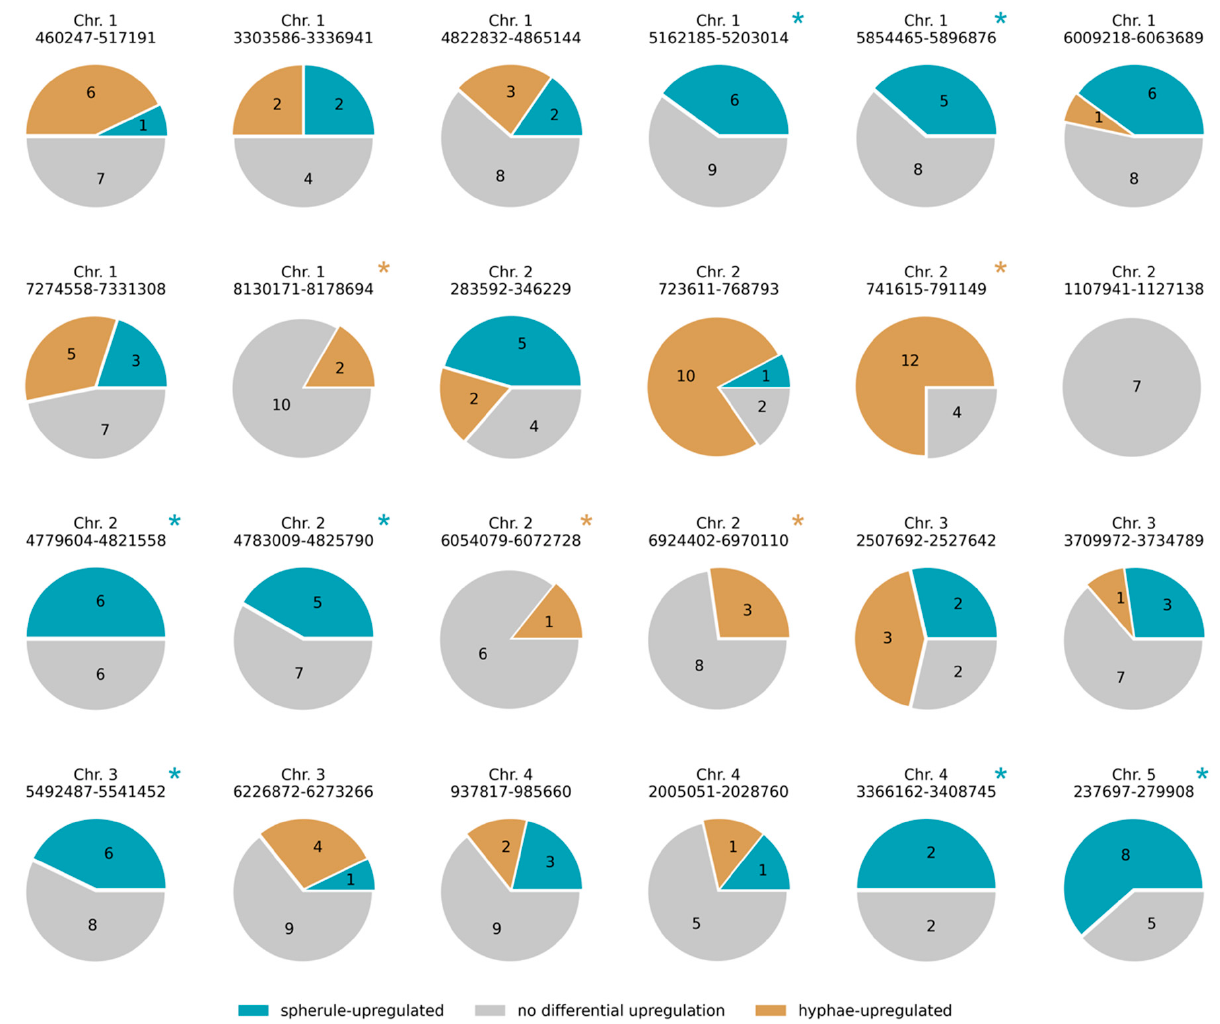
Figure 1. Secondary metabolite clusters with life cycle-specific upregulation. Each circle reports expression patterns from one secondary metabolite cluster. In a given circle, brightly colored areas and overlaid black numbers report the proportion and number, respectively, of genes in the cluster induced in the indicated life cycle phase of C. posadasii . Clusters with such expression signals in only one life cycle phase are marked with an asterisk.